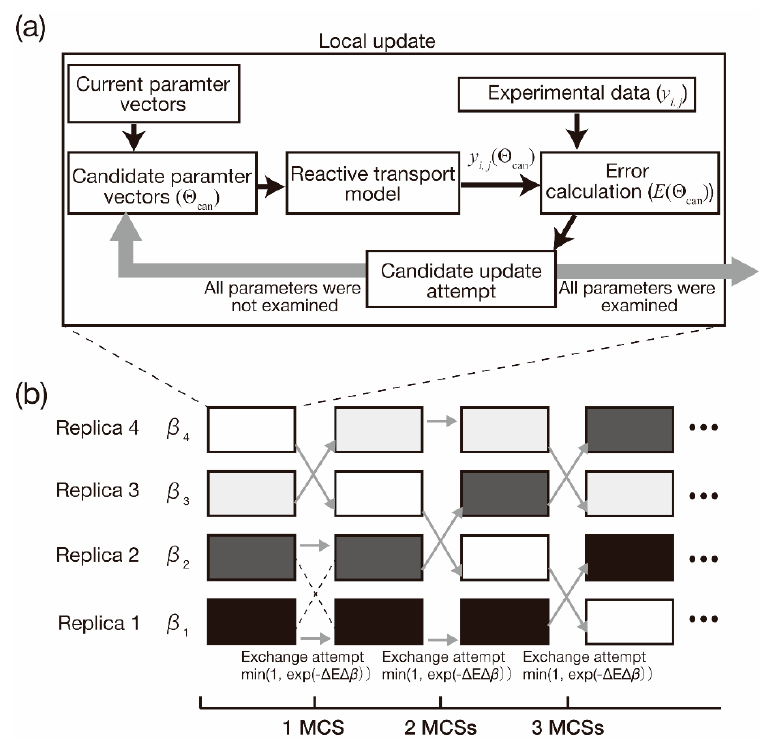
Figure 1. Schematic flow chart of the exchange Monte Carlo method for four replicate systems. ( a ) Flow chart of local update. ( b ) The local update was repeated after the exchange process. See Section 2.1 for details. MCS: Monte Carlo step.